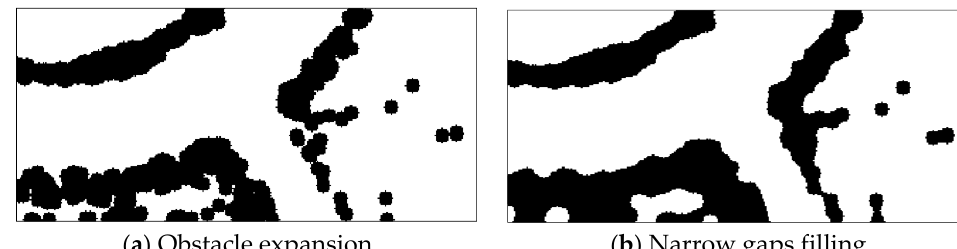
Figure 6. Obstacle description in binary